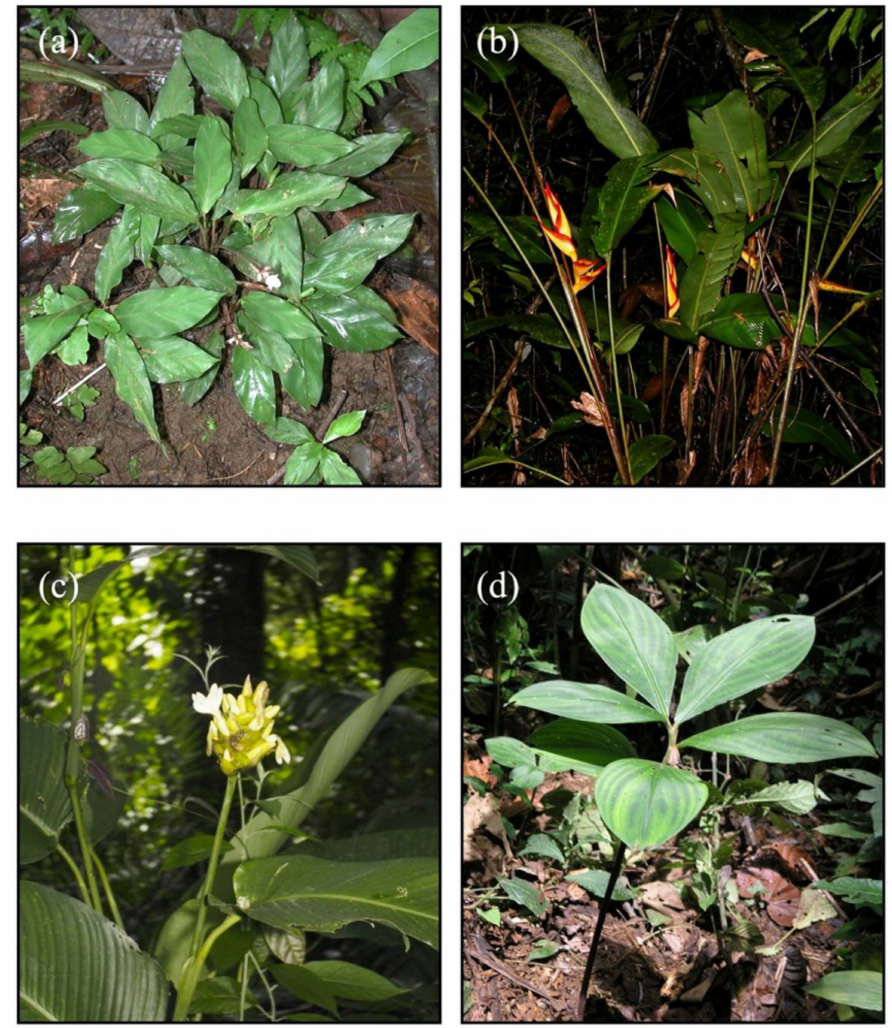
Figure 1. Understory herb species common to the understories of neotropical rain forests: ( a ) Goepper- tia micans and ( b ) Heliconia irrasa occur in forest understory habitats, while ( c ) Goeppertia marantifolia and ( d ) Costus malortieanus occur in forest edge habitats.